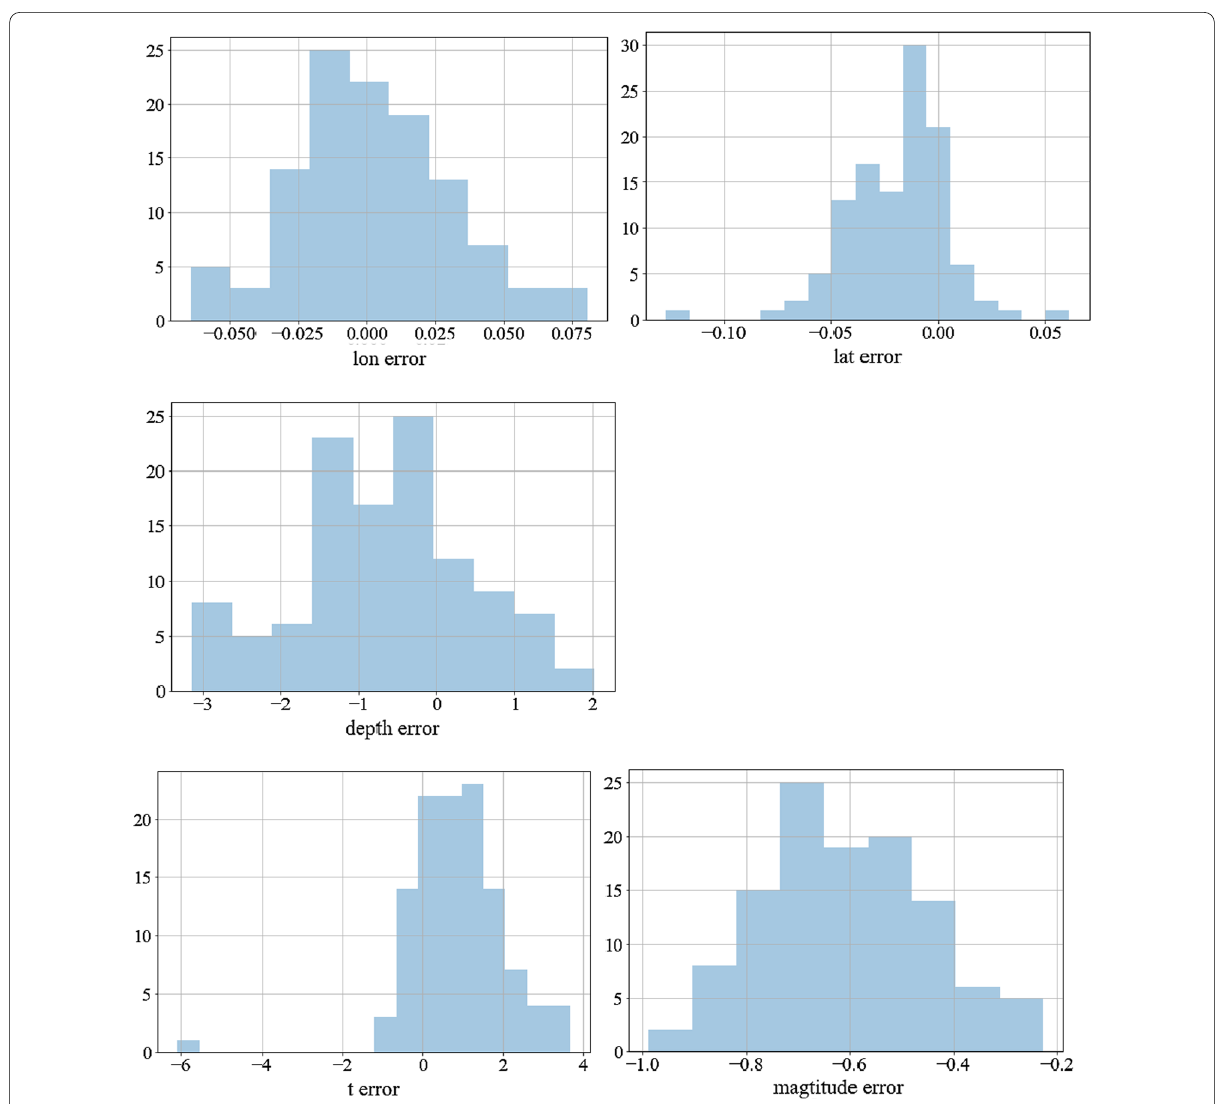
Fig. 7 Histograms of errors for hypocentral parameters determined by the proposed